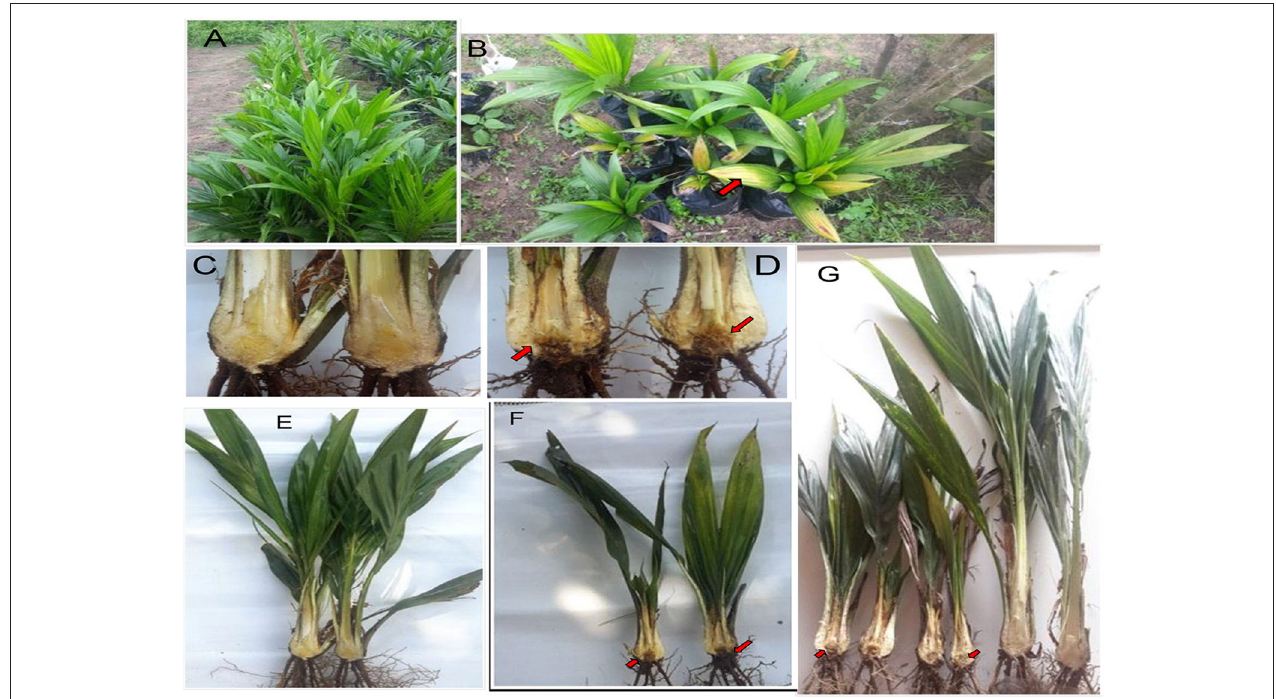
FIGURE 5 | Phenotypic evaluation of oil palm genotypes. (A,C,E) Control of oil palm seedlings with normal height and creamy bole color. (B,D,F) Arrowheads indicate infected oil palm seedlings, external and internal symptoms of Fusarium wilt disease appearing sixty days after inoculations. (G) The control of oil palm seedlings differentiated itself with normal height and creamy bole color when put side by side with the diseased seedlings which exhibited stunted growth and brownish discolouration.